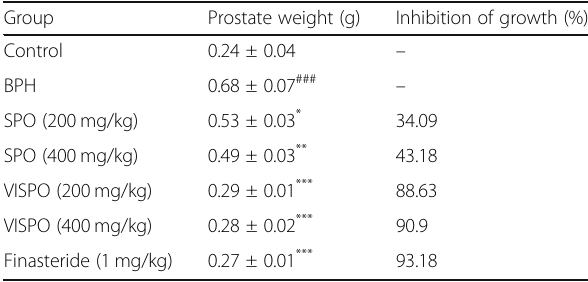
Table 1 Prostate growth in BPH model